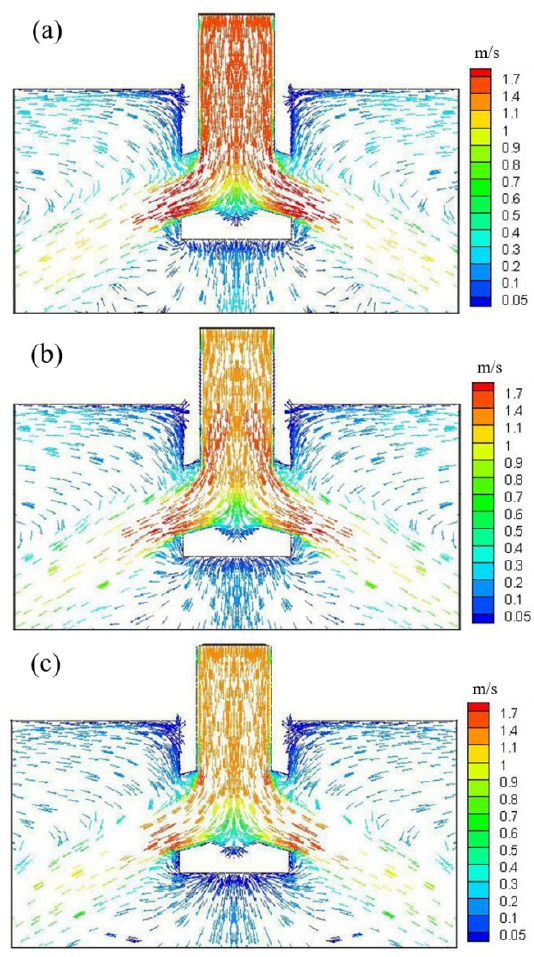
Figure 6. Locally amplified figure of the velocity vector with different SEN. ( a ) Area ratio of 0.96. ( b ) Area ratio of 1.04. ( c ) Area ratio of 1.16. Table 4. Upper and lower flow vortex core position and narrow surface impact position.